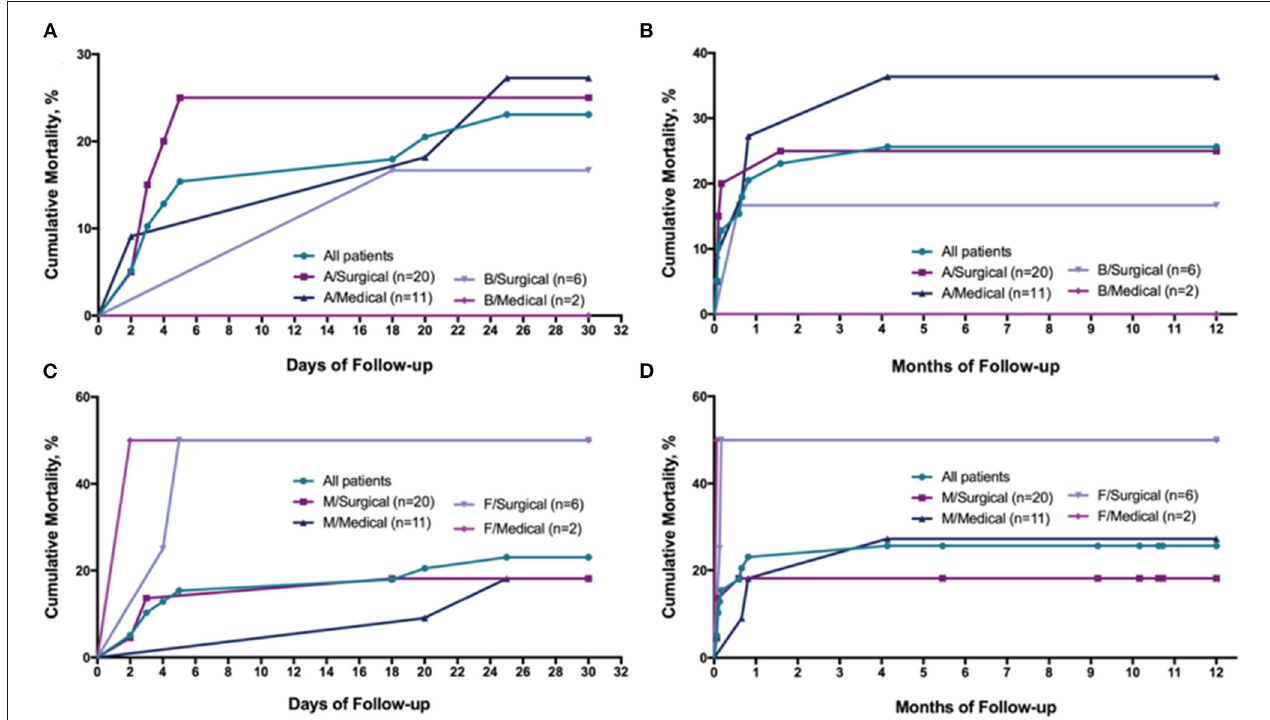
FIGURE 2 | Cumulative Mortality curves for clinical outcomes in the 39 patients with AD with AMI. (A) , Cumulative Mortality curves for 30 days between Type A and Type B; (B) , Cumulative Mortality curves for 12 months between Type A and Type B; (C) , Cumulative Mortality curves for 30 days between men and women; (D) , Cumulative Mortality curves for 12 months between men and women; AD indicates aortic dissection; AMI, acute myocardial